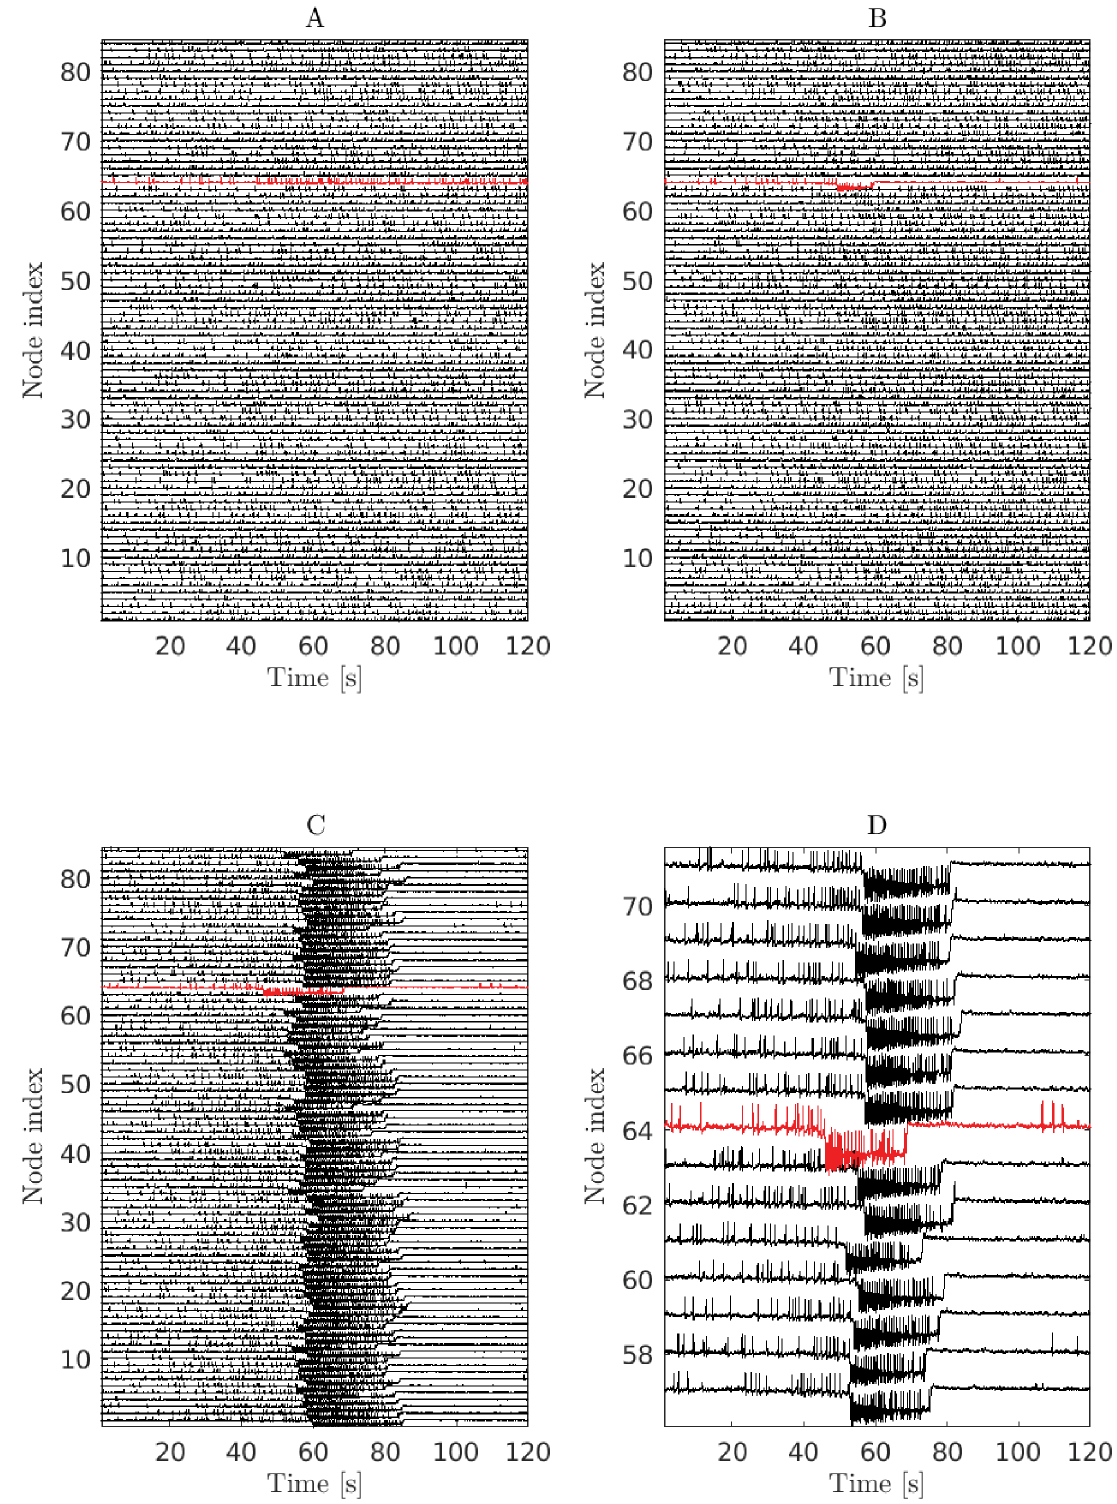
Fig 1. Seizure spread in the epileptor-network model. Three qualitatively different behaviors are observed for different global connectivity strength ( w ) and surrounding-node excitability ( x 0 ) parameter values. Figures show simulations of the epileptor network model for patient P1. Node 64 was identified as the target active EZ node ( x 0 = − 1.6). The standard deviation of the noise input level was